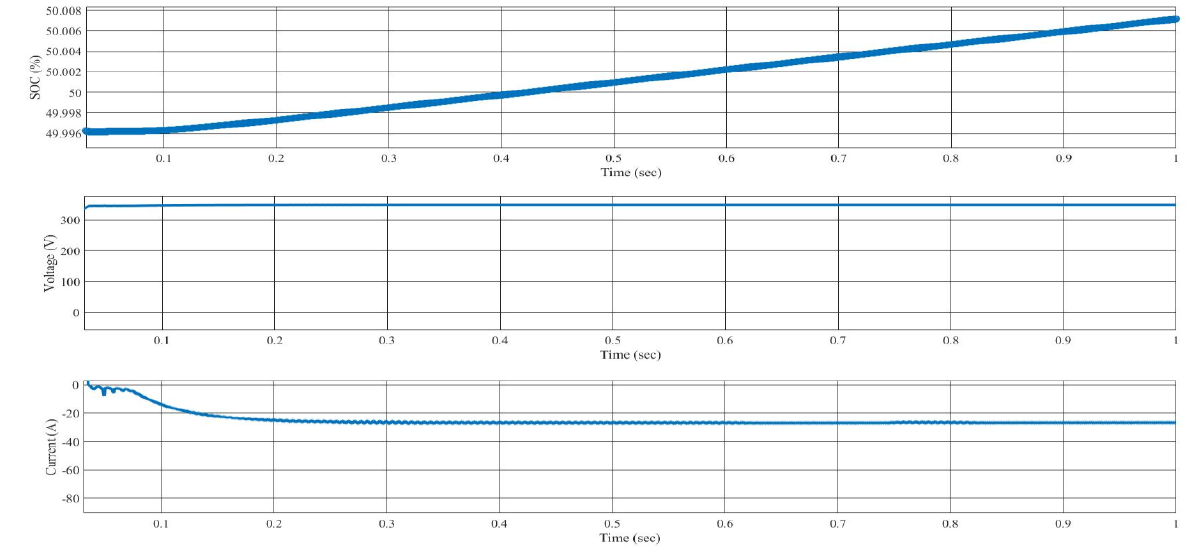
Figure 15. Charging the EV’s battery from the supercapacitor alone.